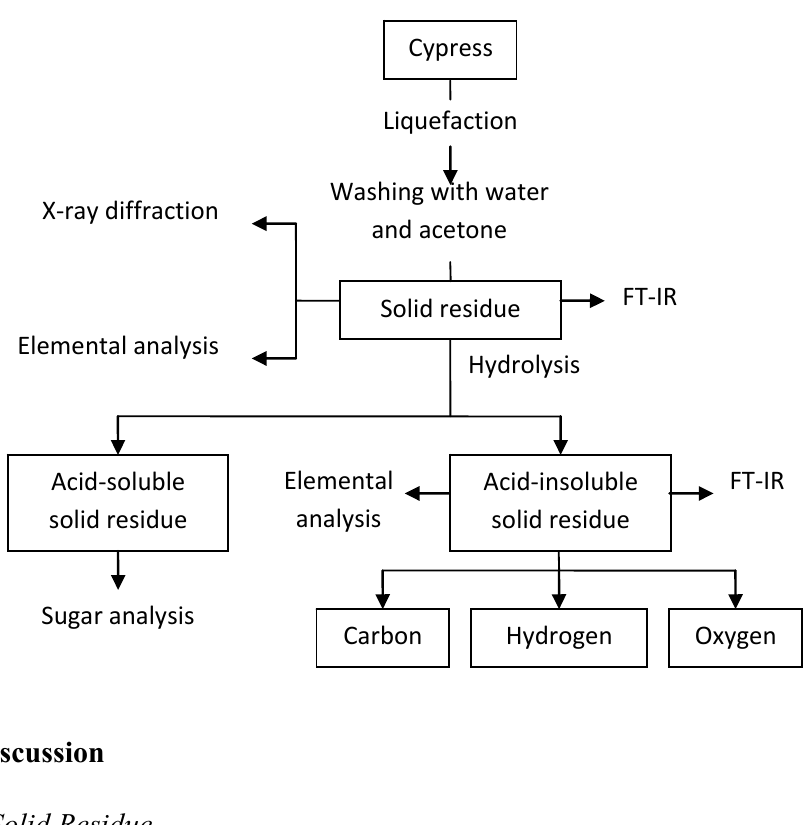
Figure 1. A brief scheme of the product separation and analysis